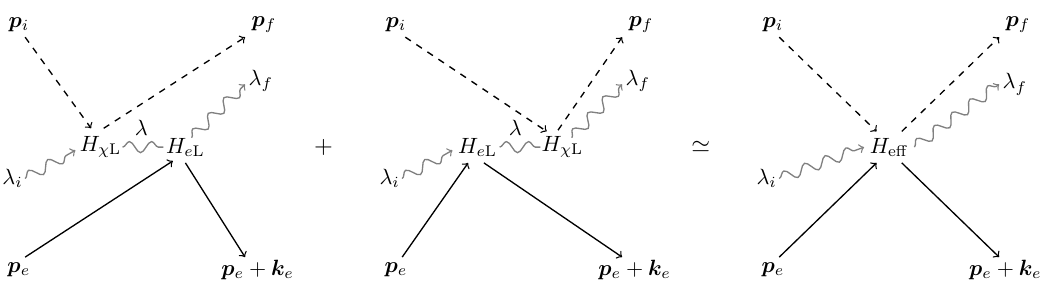
Figure 2. Schematic representation of the EFT procedure applied to the result of old-fashioned perturbation theory. Each line corresponds to a state in the Hilbert spaces of the dark matter ( dashed ), electron ( solid ), and crystal lattice ( wavy ). The intermediate lattice mode has high frequency and, when integrated out, it leads to an effective Hamiltonian that is local in time and independent on the complicated dynamics of the